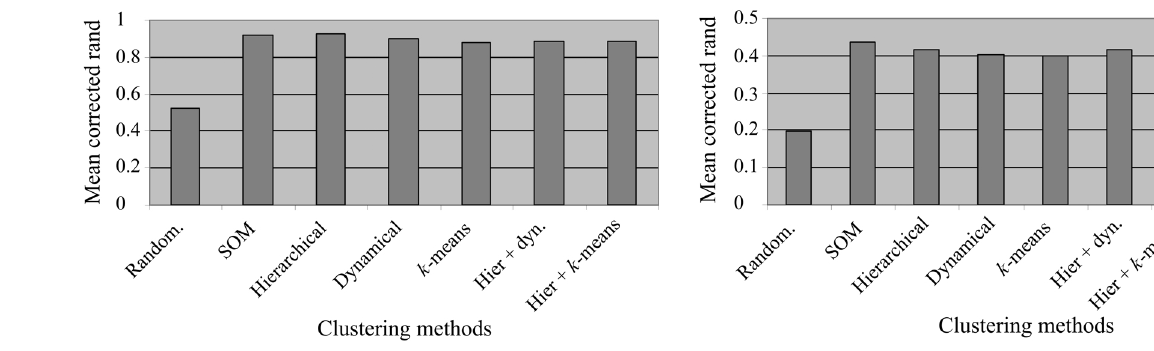
Figure 2 - Mean of corrected Rand values from the Reduced FC Yeast All experiments.